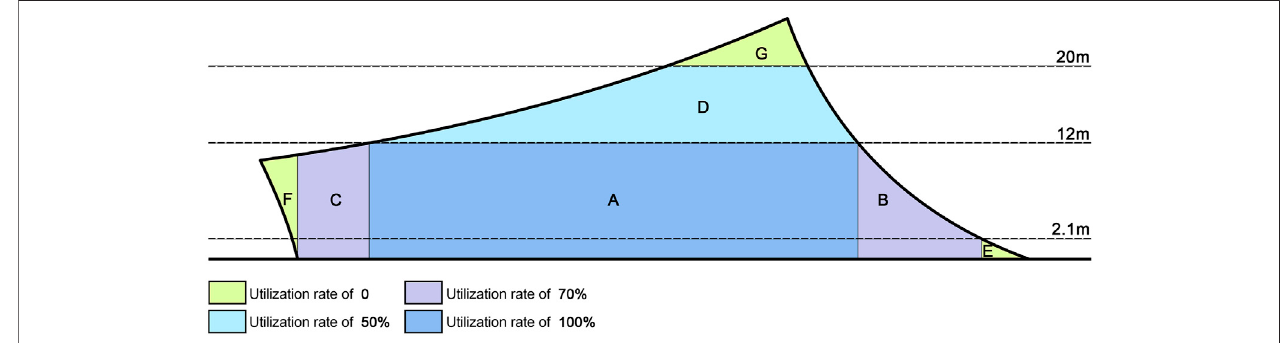
FIGURE 5 | The number of node variable changes under the constraint.